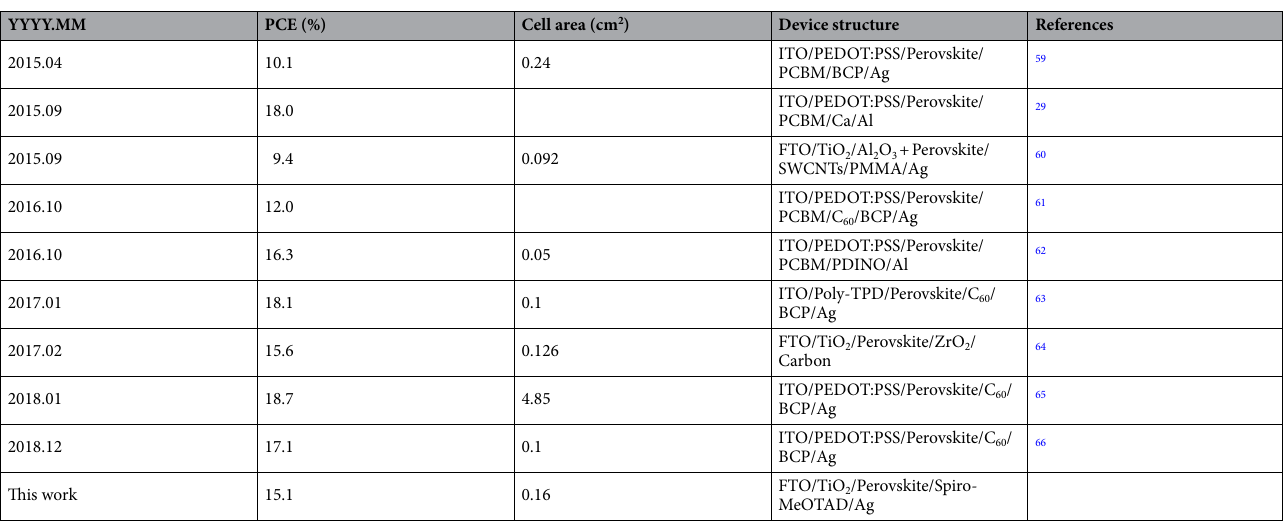
Table 3. Efficiency comparison of the results of other group reported in ambient air process perovskite solar cell.